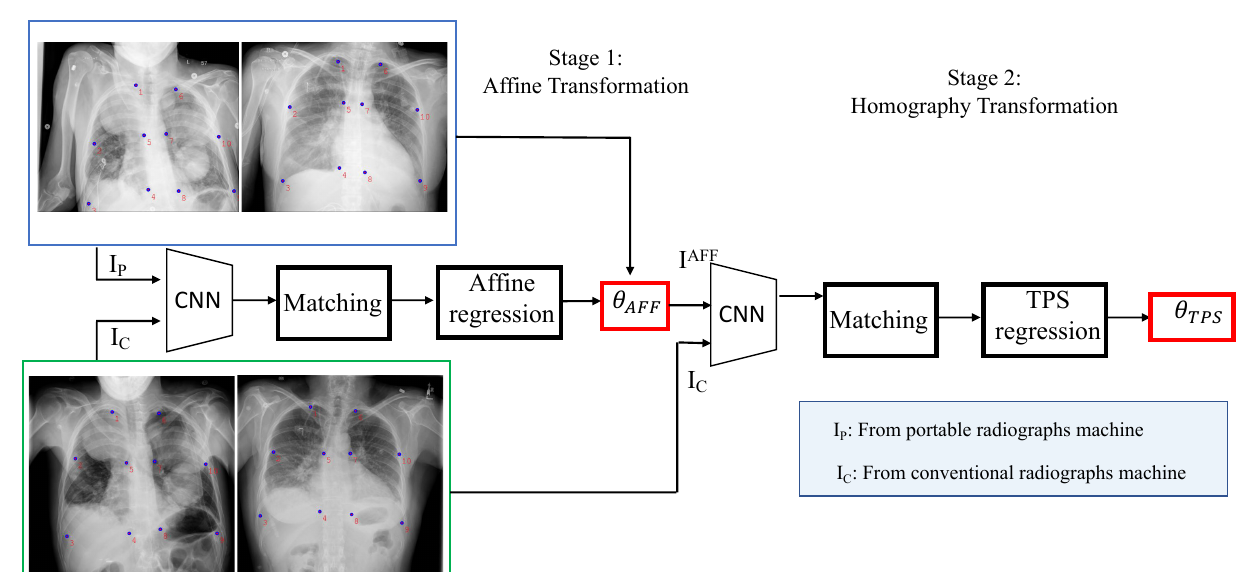
Figure 4. The flowchart of training portable radiograph alignment. The input is a pair-subject dataset and the model output is affine transformation (six degrees-of-freedom) θ AFF and homography transformation θ TPS .